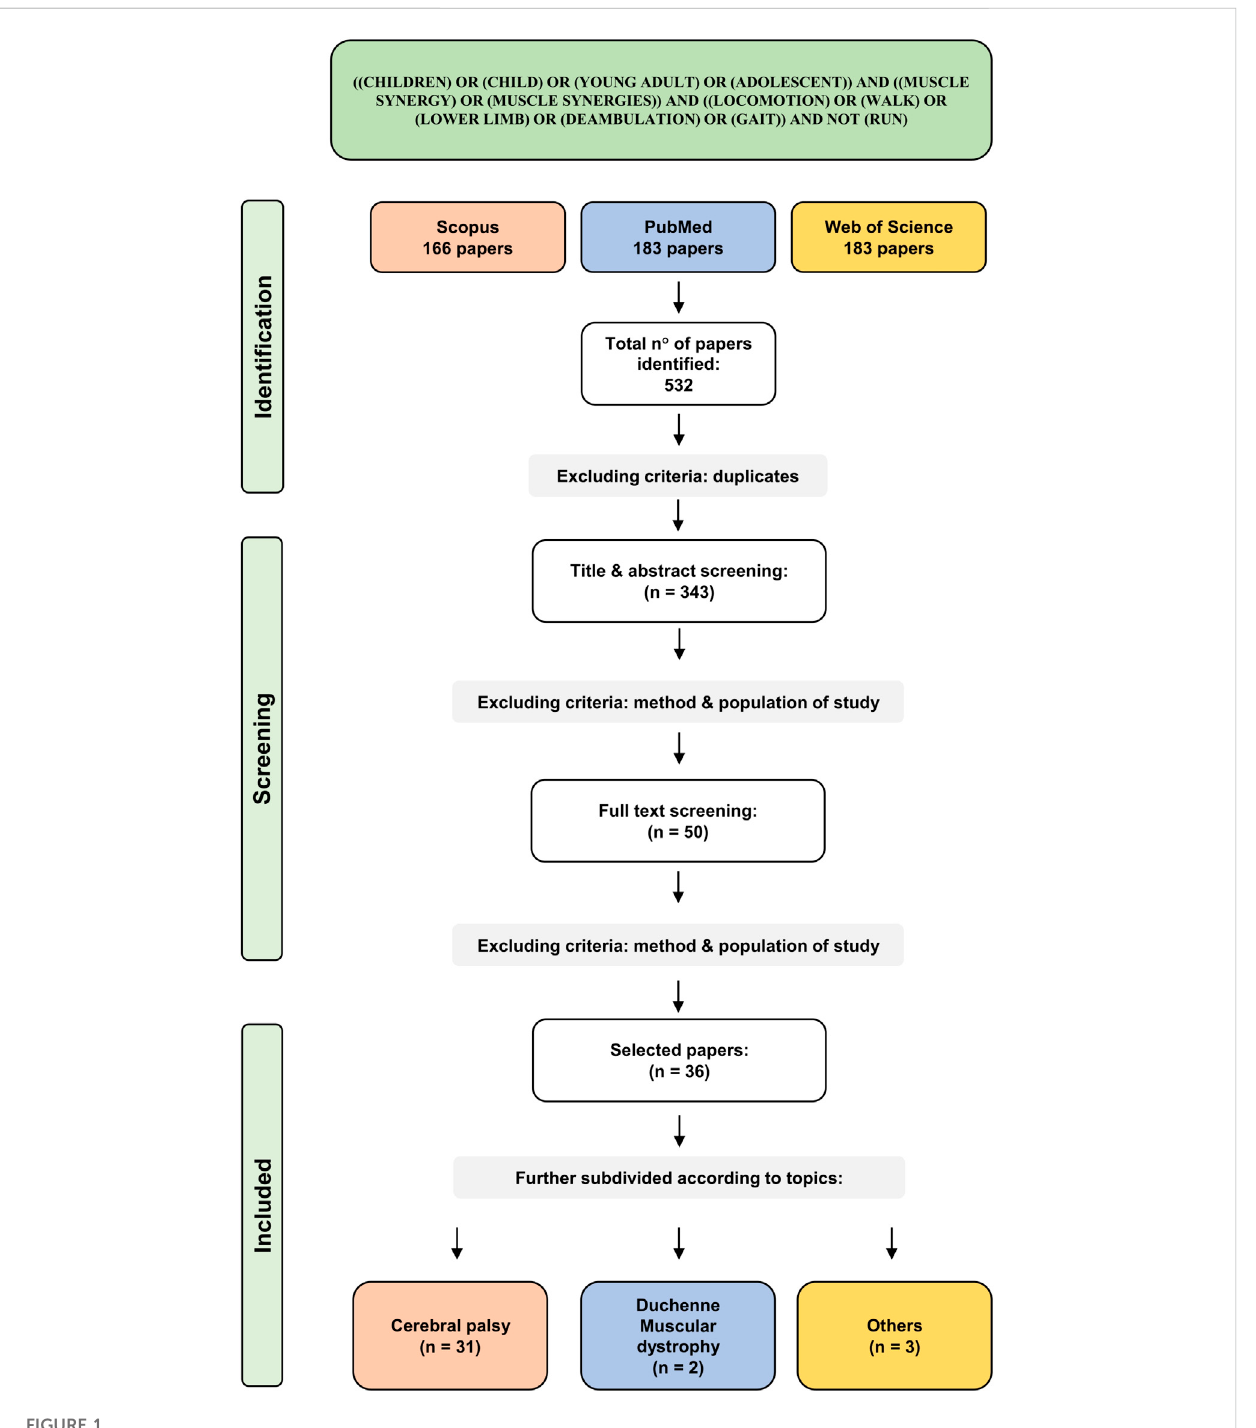
FIGURE 1 Prisma fl owchart of the included